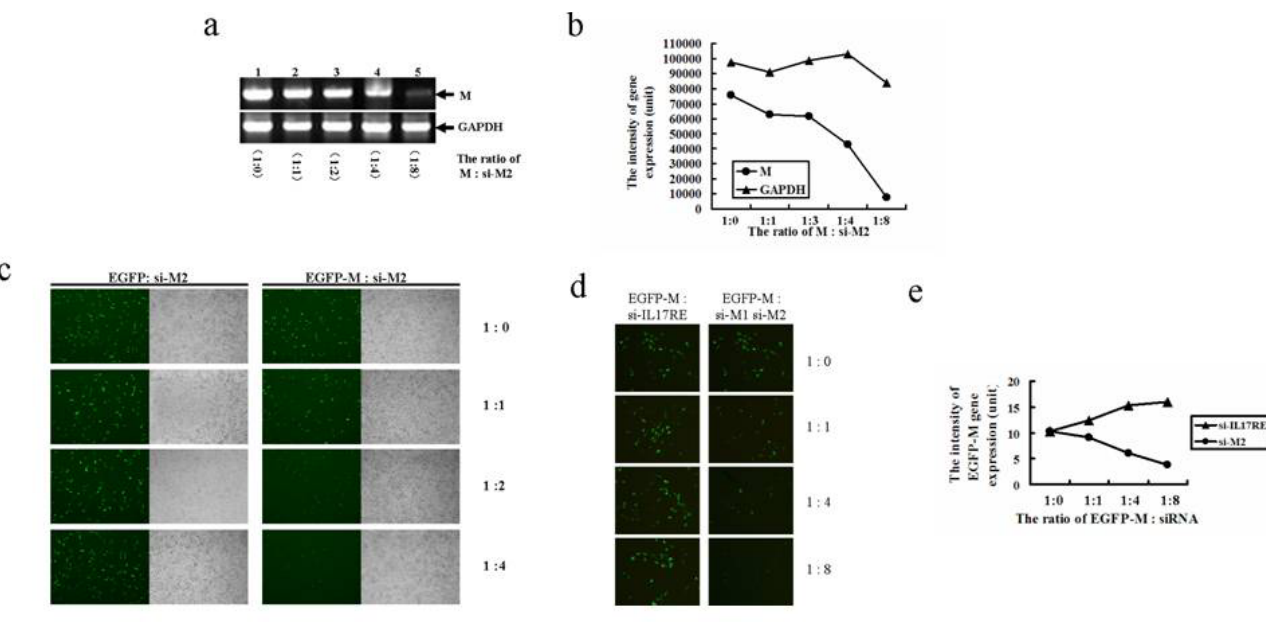
Figure 4. The inhibitory effect of siRNA2 on SARS-CoV M gene expression. (a) RT-PCR analysis on the dose effect of si-M2 on M mRNA expression. About 1  g of pCMV-Myc-M was co-transfected with increased doses of si-M2. The reaction products were subjected to RT-PCR analysis using SARS-M and GAPDH primers. (b) Quantitation of the RT-PCR results in (a). (c) si-M2 specifically inhibited pEGFP-M fusion gene but not pEGFP gene expression. About 1  g of either pEGFP-M or pEGFP was co-transfected with increased doses of si-M2. (d) si-M2 but not si-IL-17RE effectively inhibited pEGFP-M gene expression. About 1  g of pEGFP-M plasmid was co-transfected with increased doses of either si-M2 or si-IL17RE. (e) Flow cytometric analysis on the intensity of pEGFP-M gene expression in